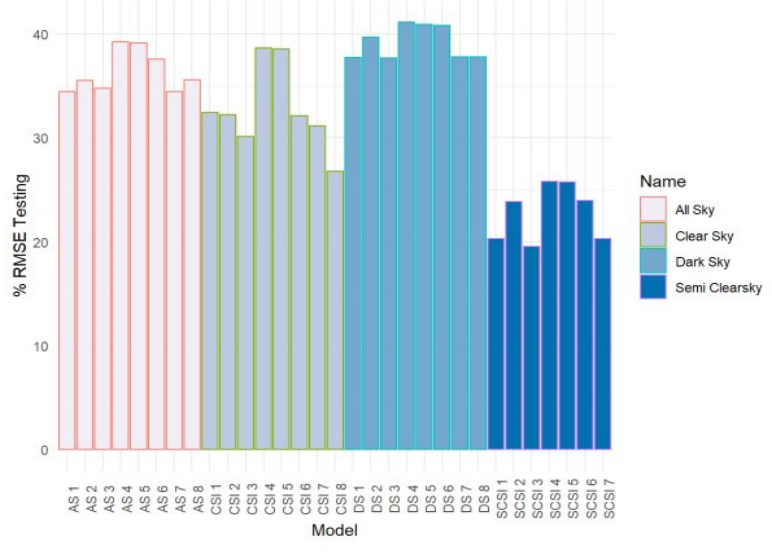
Figure 18. RMSE for testing models. Figure 19 details each of the testing models generated, with their MBE bias errors.